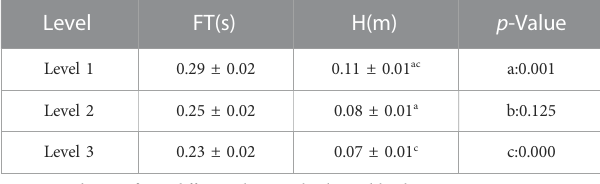
a Represented a signi fi cant difference between level 1 and level 2, p < 0.05. b Represented a signi fi cant difference between level 2 and level 3, p < 0.05. c Represented a signi fi cant difference between level 3 and level 1, p <